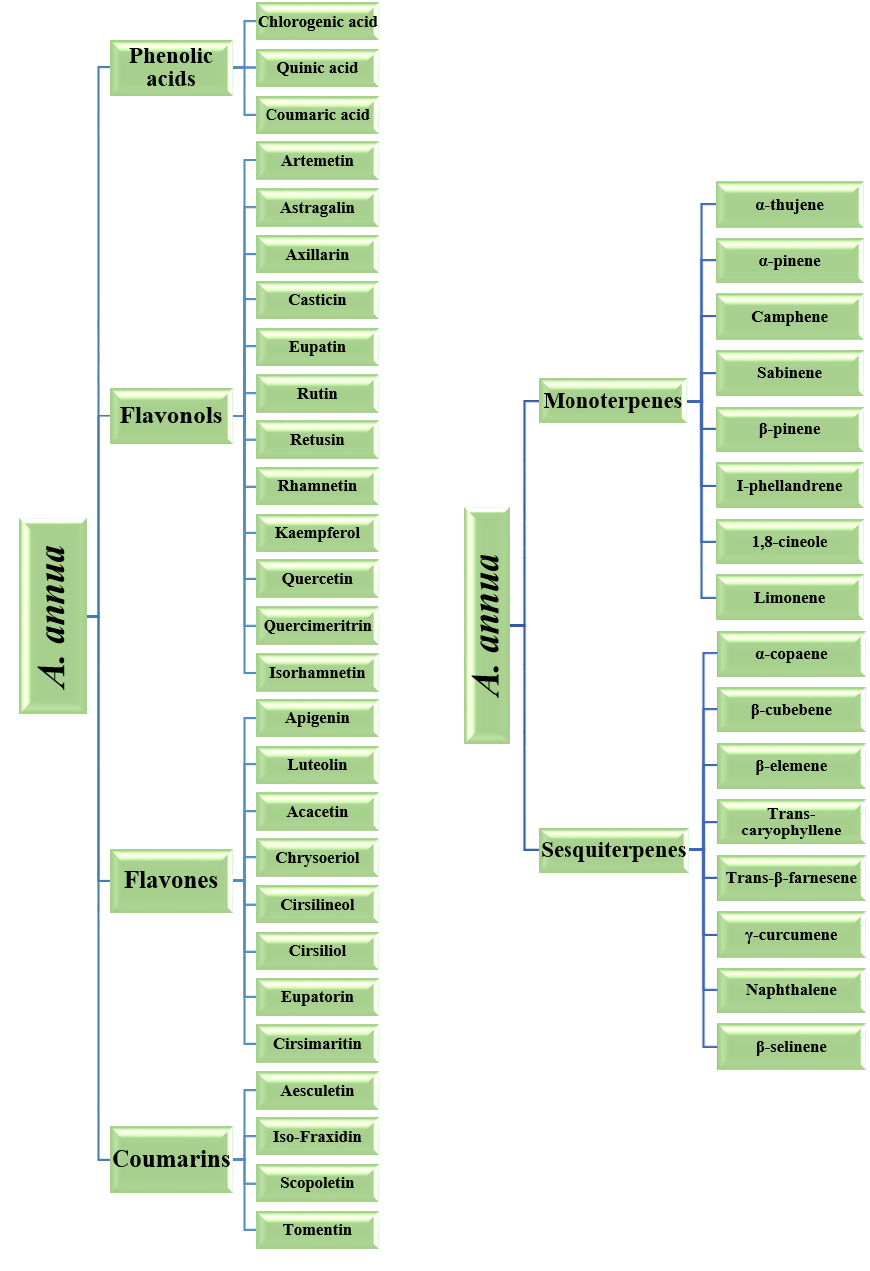
Figure 10. Illustration of the various bioactive compounds found in A. annua [17].